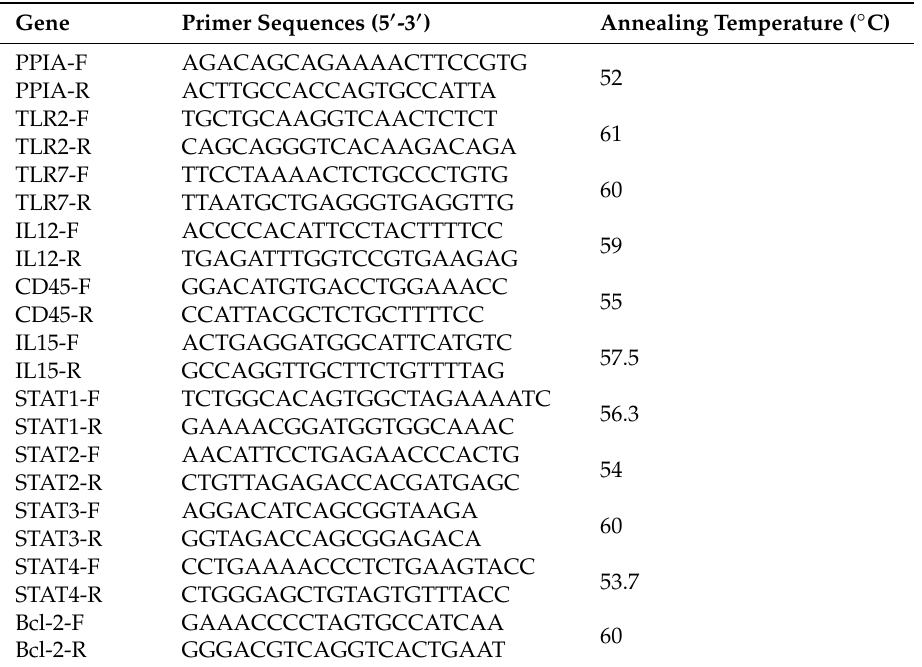
Table 2. Primer sequences and annealing